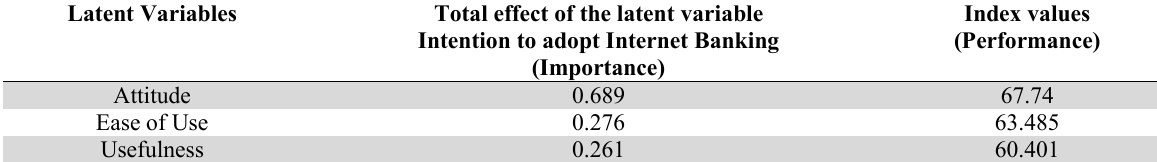
Index Values and Total Effects